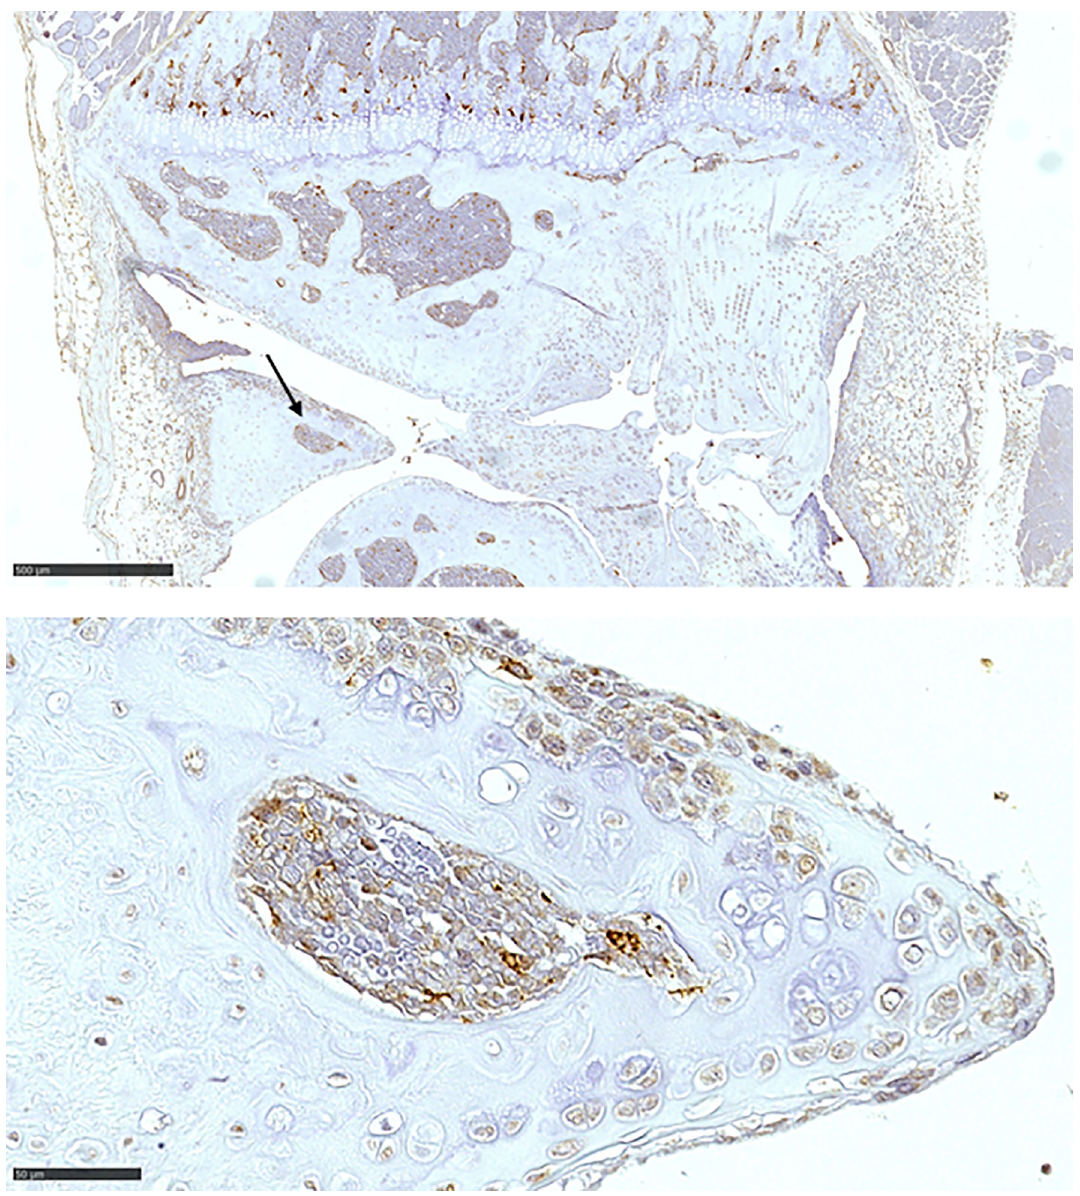
Fig 2. Representative illustration of CD68 + stained cells in the meniscus of a na ï ve mouse. (a) shows staining in cells within the subchondral bone as well as in bone marrow areas inside the meniscus (arrow; original x 50); (b) shows positive staining in cells in the meniscus border as well as in cells inside the bone marrow space (original x 400); bar indicates 50 μ M.